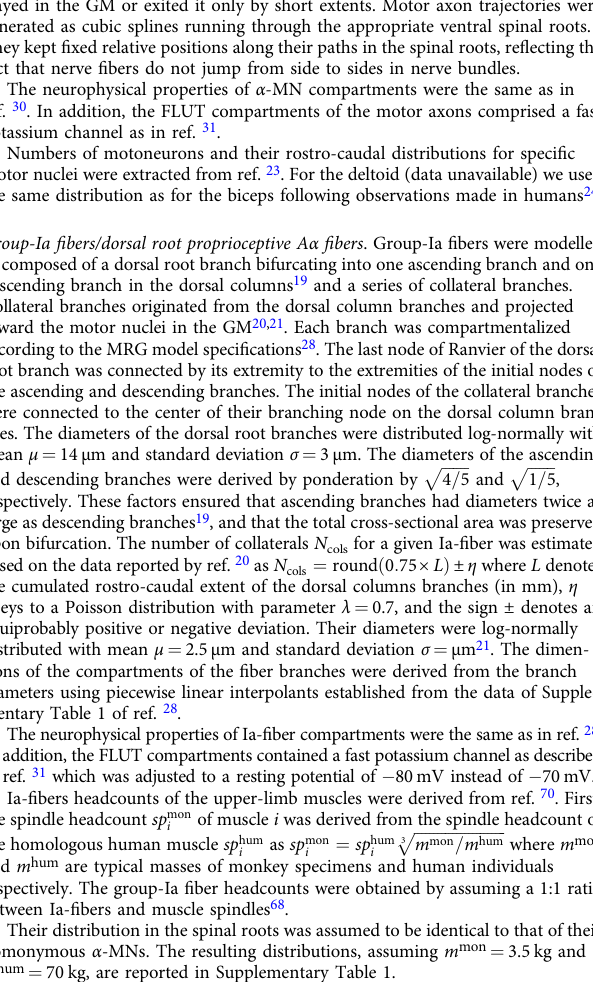
Recruitment curves . Figure 2. Populations of N = 50 nerve fi bers or motoneurons were simulated for stimulation with multiple electrode contacts and stimulus amplitudes. A nerve fi ber or motoneuron was considered recruited when an